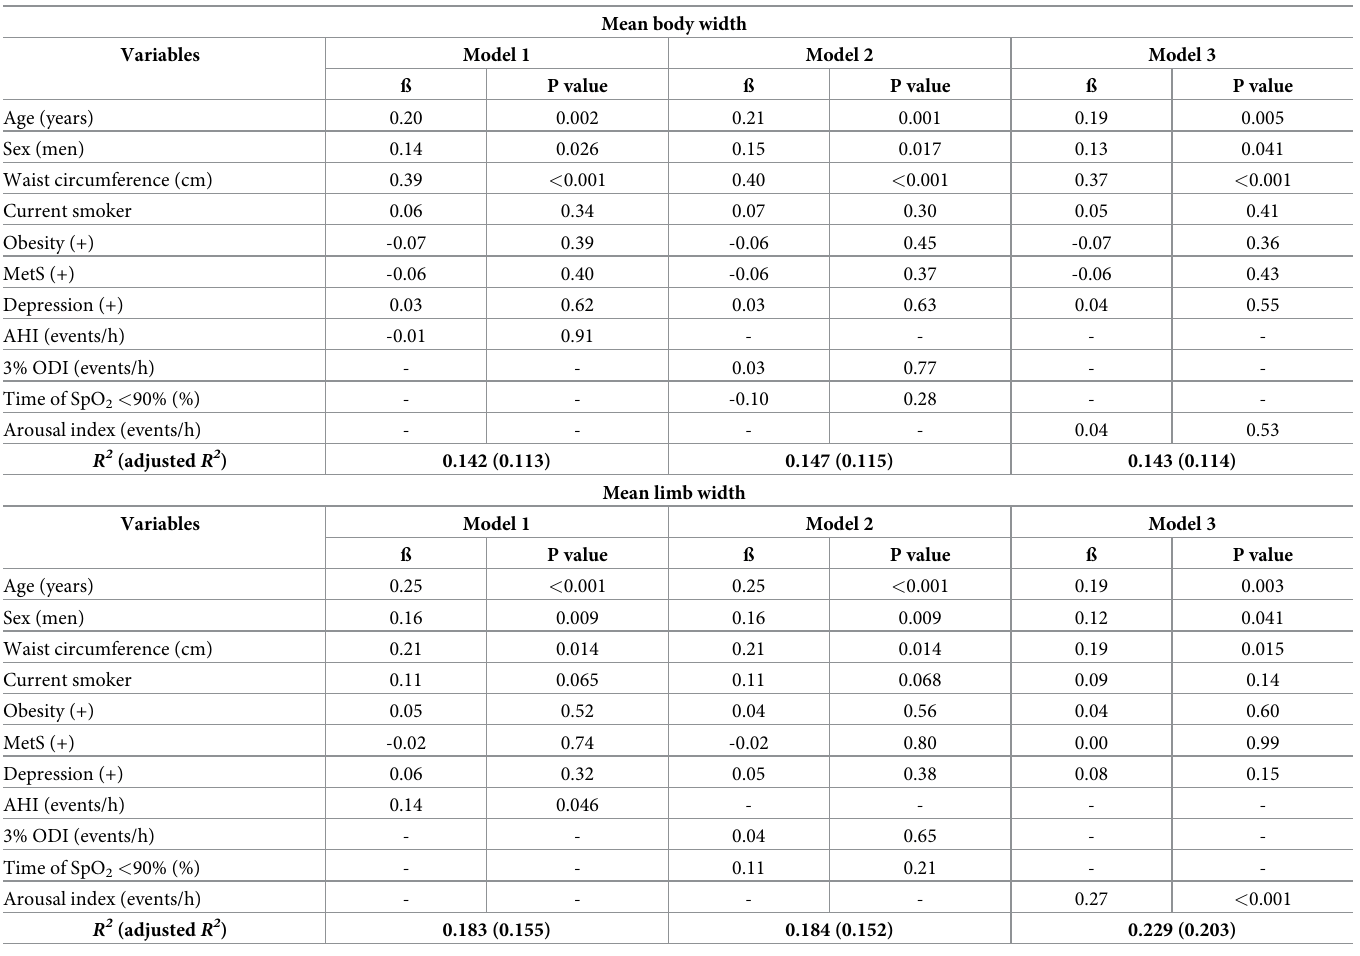
Table 3. Multivariate regression analysis for mean of bodies and limbs. n =